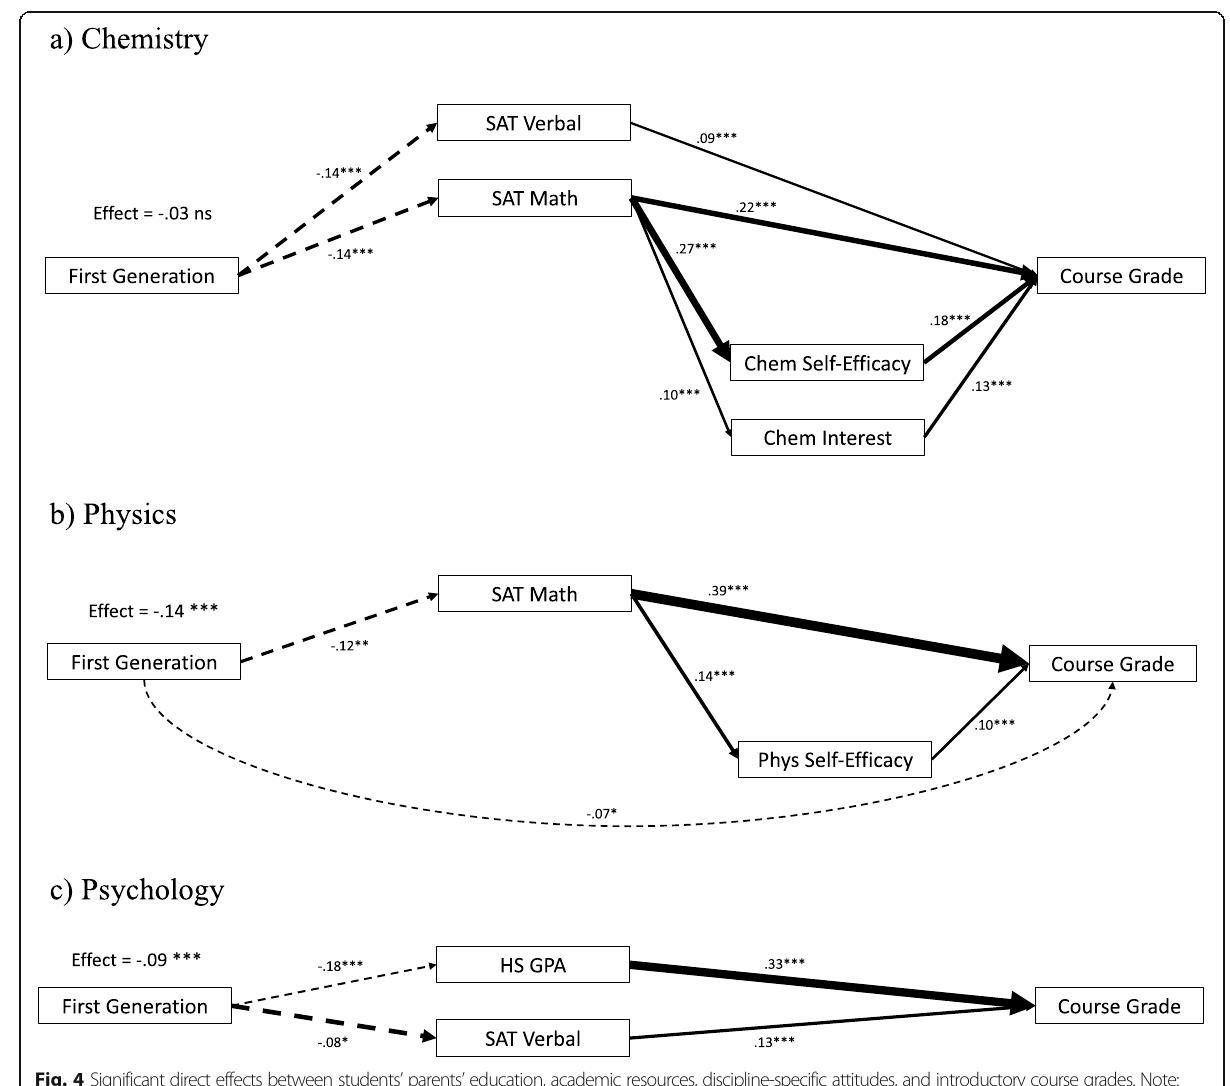
Fig. 4 Significant direct effects between students ’ parents ’ education, academic resources, discipline-specific attitudes, and introductory course grades. Note: Solid arrows indicate significant direct effects, dashed arrows indicate significant negative direct effects, and line thickness denotes the size of the standardized path coefficient. These figures only display pathways with significant indirect effects relevant to course grade outcomes, see Fig. 5 for all significant pathways. The final models for each course provided good fits to the data: chemistry RMSEA < .01 (90% CI .00, .03), CFI > .99, and TLI > .99; physics RMSEA = 0.01 (90% CI 0.00, 0.03), CFI > .99, and TLI > .99, and psychology RMSEA = 0.02 (90% CI 0.00, 0.03), CFI > .99, and TLI = .99. *** p < .001. ** p < .01. * p < .05. +p <